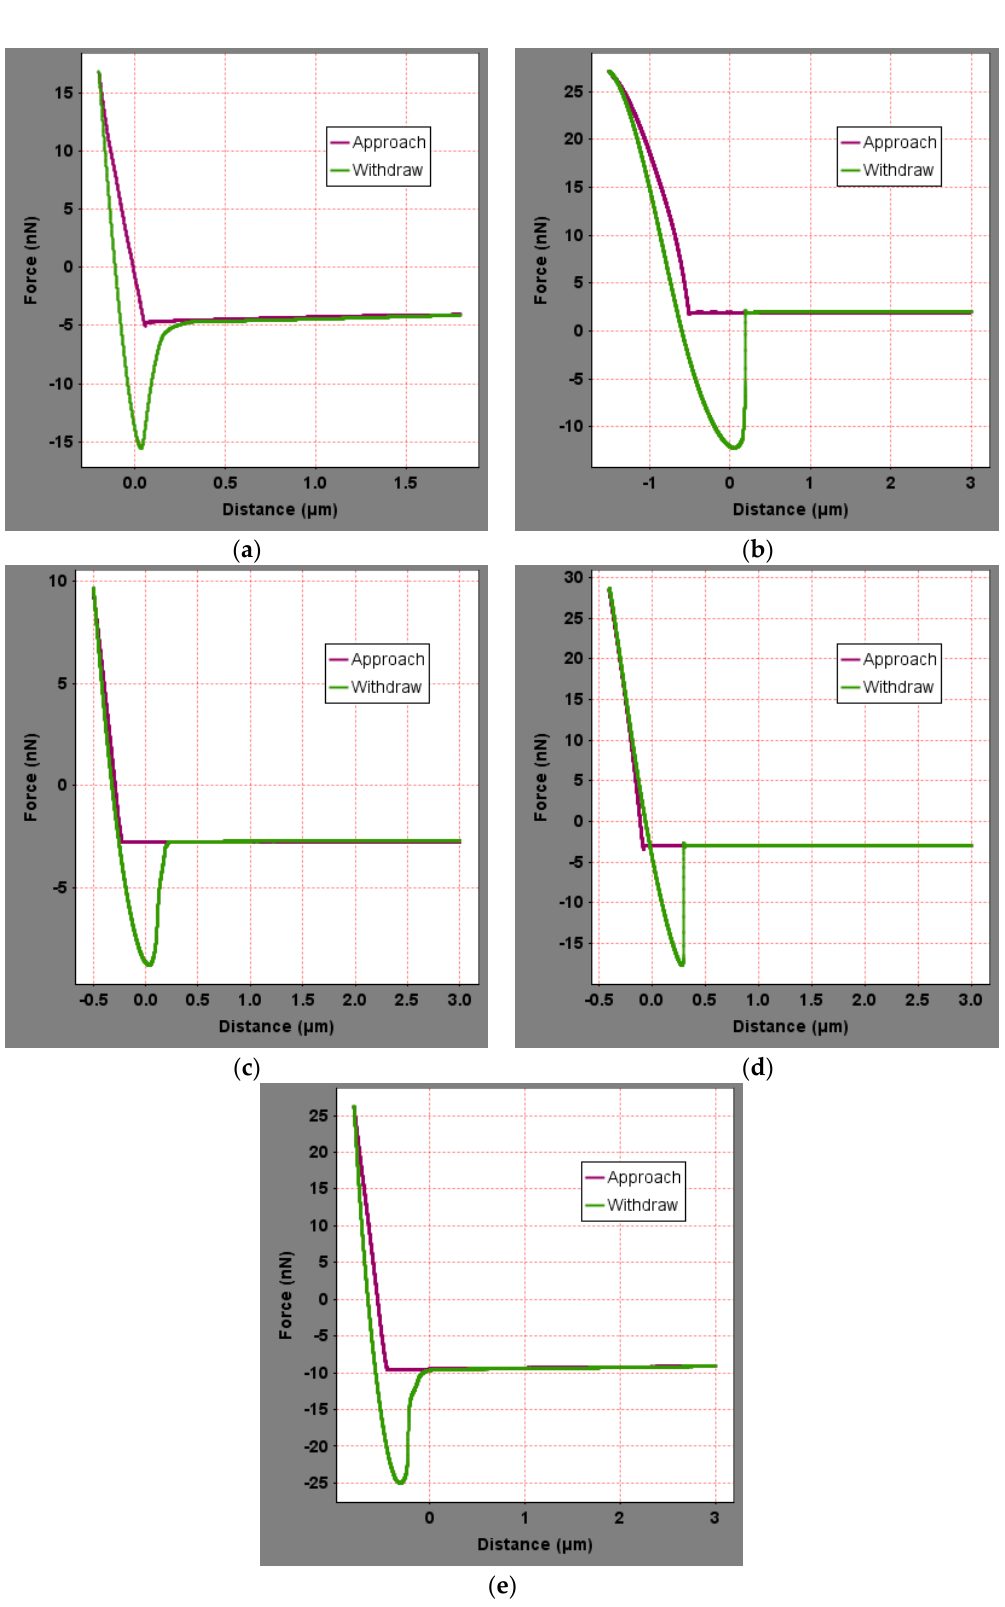
Figure 12. Force curves of the valley region of the bee-like structures in aged asphalts: ( a ) SK-70; ( b ) SK-90; ( c ) KL-70; ( d ) Shell-70; and ( e ) SBS-modified.